Question: Summarize what this figure shows in one sentence.
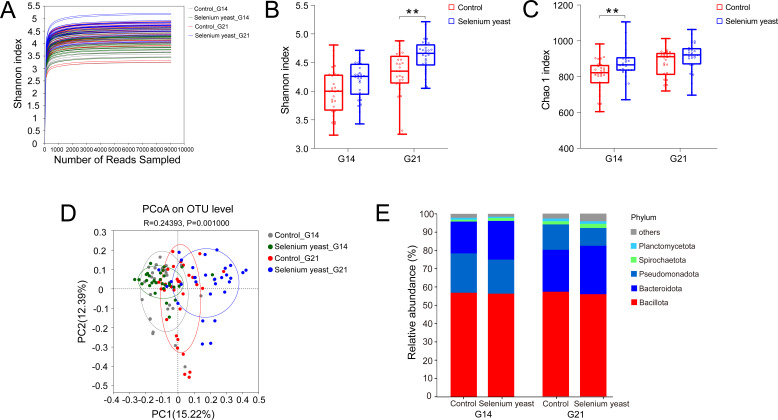
Answer: Comparison of intestinal microbiota composition between control and selenium yeast-supplemented sows on gestation days 14 and 21. ( A ) Rarefaction curves of bacteria between control and selenium yeast supplemented sows, with all samples rarefied to 9,075 sequences per sample prior to analysis. Comparison of microbial community diversity, measured by the Shannon index ( B ) and Chao1 index ( C ), between control and selenium yeast-supplemented sows. ( D ) PCoA based on Bray–Curtis distances of operational taxonomic unit (OTU) profiles between control and selenium yeast-supplemented sows. ( E ) Fecal microbial community composition at the phylum level in control and selenium yeast-supplemented sows. Statistical analyses were performed using the Mann–Whitney U test ( B and C ). ** P < 0.01. n = 30.